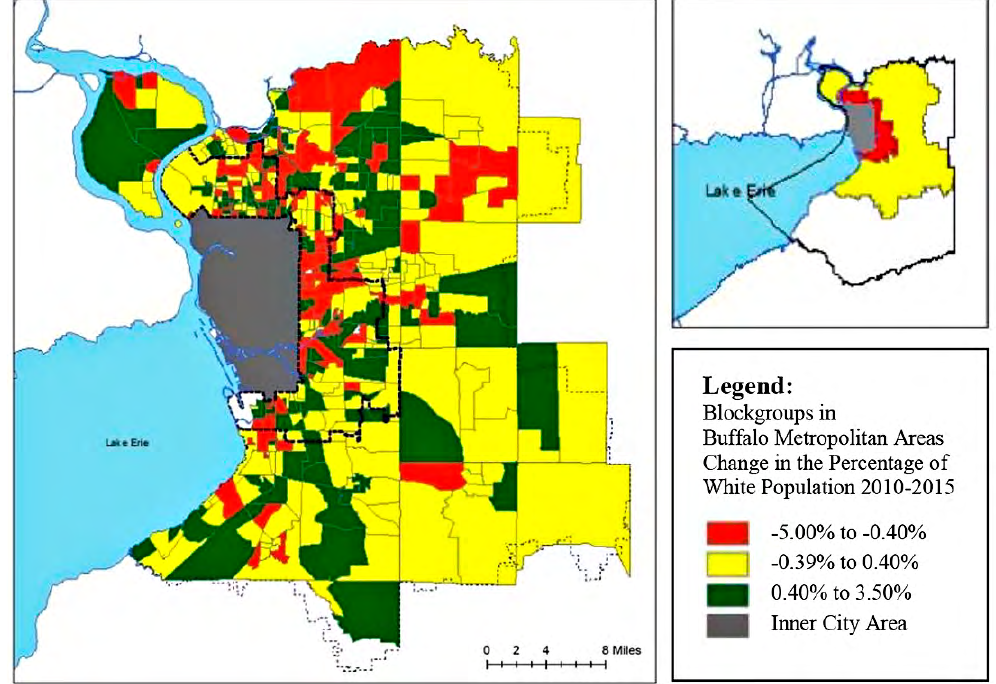
Figure 2. The first component contributing to Neighbourhood Change between 2010-2015 (The change in racial composition: White